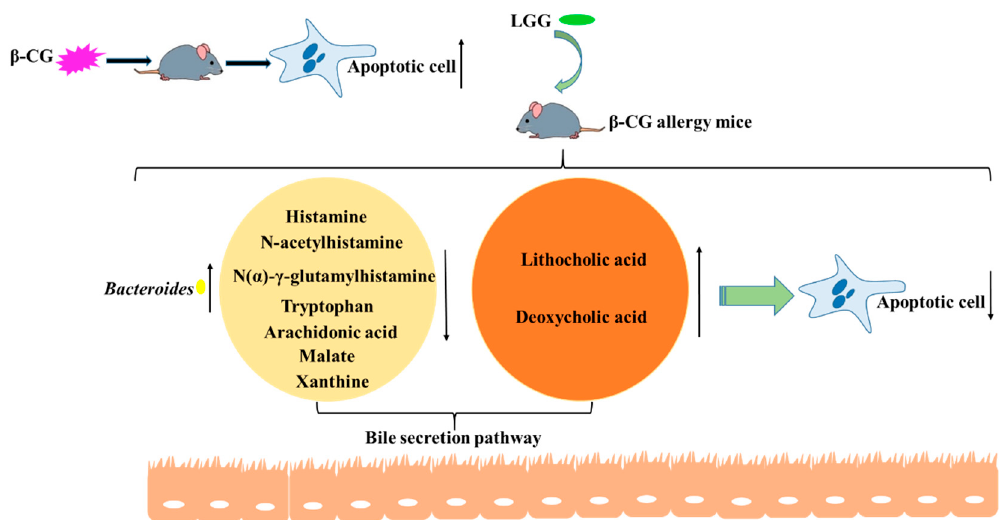
Figure 8. Mechanism of LGG reducing apoptotic cells through regulating Bacteroides levels and the bile secretion pathway.